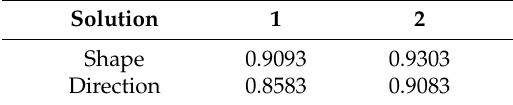
Table 7. Shape similarity and direction relationship similarity of each matching solution.